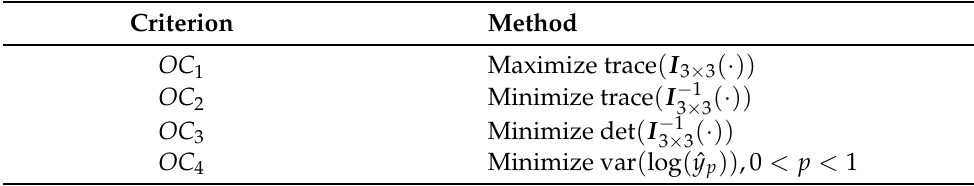
Table 1. Some practical censorship plan optimal